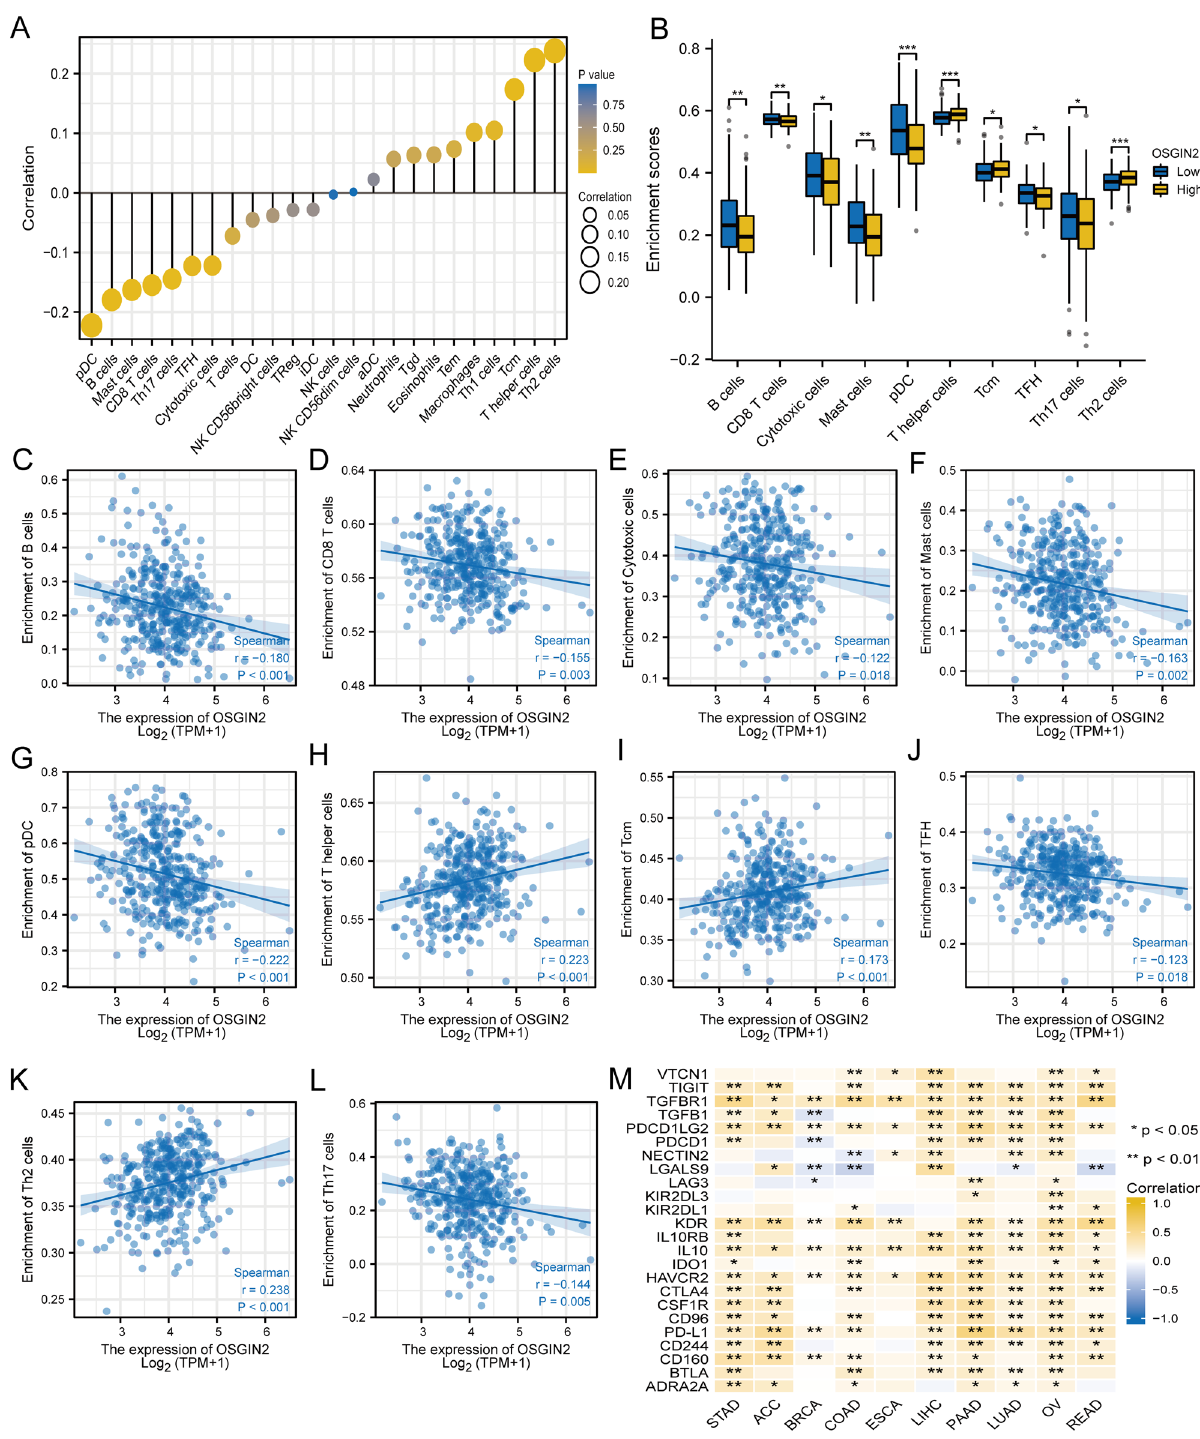
Figure 5. Correlation of OSGIN2 with immune infiltration ( A ) Lollipop diagram of the correlation between OSGIN2 and 24 types of immune cells. ( B ) The difference in the Infiltration fraction of 10 immune cells (Th2 cells, T helper cells, TCM, pDC, B cells, Mast cells, CD8 T cells, Th17 cells, TFH, and Cytotoxic cells) in the OSGIN2 high or low expression groups. ( C–L ) Correlation coefficient between the infiltration levels of the above 10 immune cells and OSGIN2 expression in gastric cancer. (M) Immune-related biomarkers correlate with OSGIN2 expression in multiple tumors. ns p ≥ 0.05; * p < 0.05; ** p < 0.01; *** p <